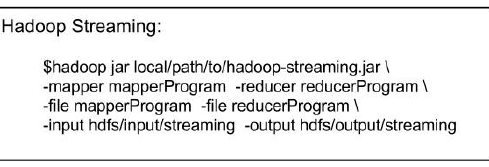
Fig. 7. Hadoop Streaming: Command Line